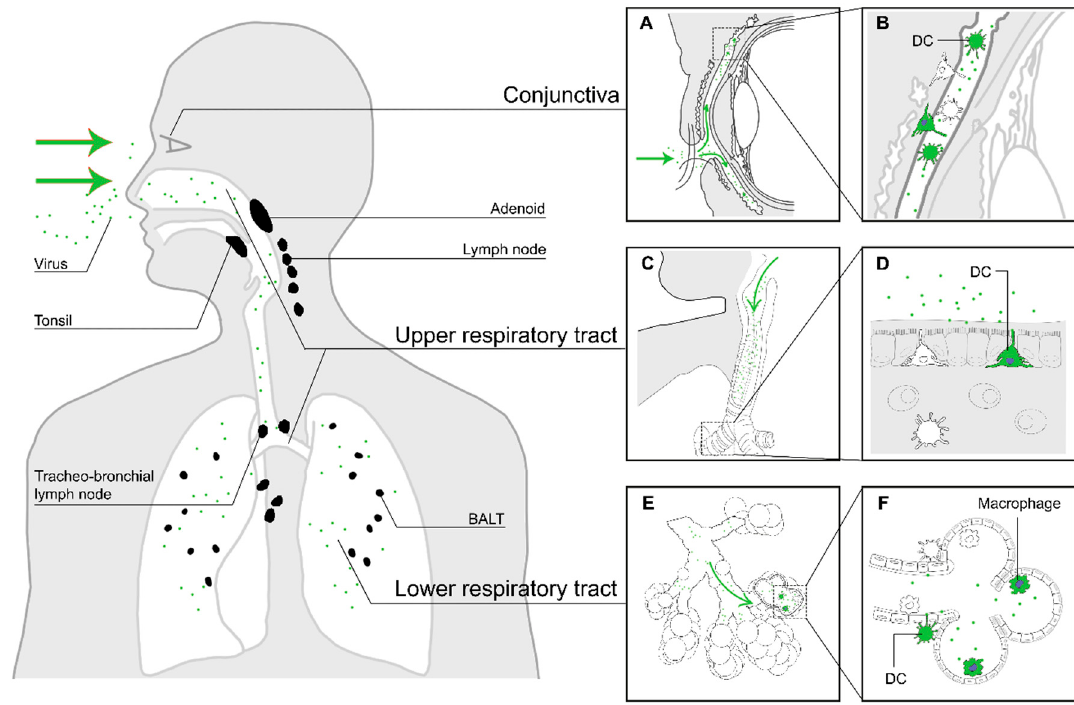
Figure 1. The first stage of MV infection: entry of MV into a susceptible host. The virus enters the respiratory tract (green arrows in panels ( C ) and ( E )), where it binds to DC-SIGN + DCs or infects CD150 + myeloid or lymphoid cells in the mucocilliary epithelium or the alveolar spaces. Another potential site of entry is through the conjunctiva, which is rich in DCs and CD150 + lymphocytes ( A ). Panels on the right show an enlarged illustration of potential entry events. MV particles deposited on the conjunctiva will enter the space between cornea and eyelids (( A ), green arrows), where they can infect myeloid or lymphoid cells ( B ). MV particles inhaled into the respiratory tract (( C ) and ( E ), green arrows) can either infect DC-SIGN + dendritic cells in the upper respiratory tract, with dendrites protruding into the respiratory mucosa ( D ), or dendritic cells or macrophages in the alveolar lumina of the lower respiratory tract ( F ). The infected immune cells subsequently migrate to nearby tertiary lymphoid tissues and draining lymph nodes (black).